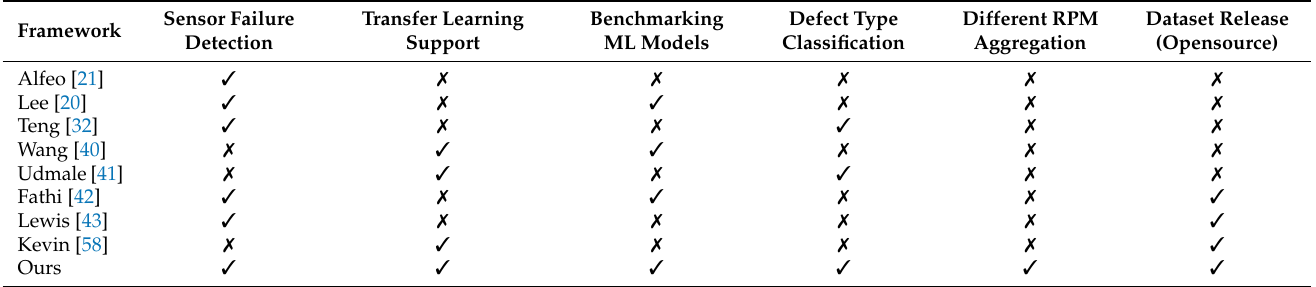
Table 8. A comparative analysis of the available features between the prior related works in smart manufacturing and our framework. Our work provides a failure detection framework that incorporates transfer learning between different sensor types. Our framework also considers RPM aggregation and defect type